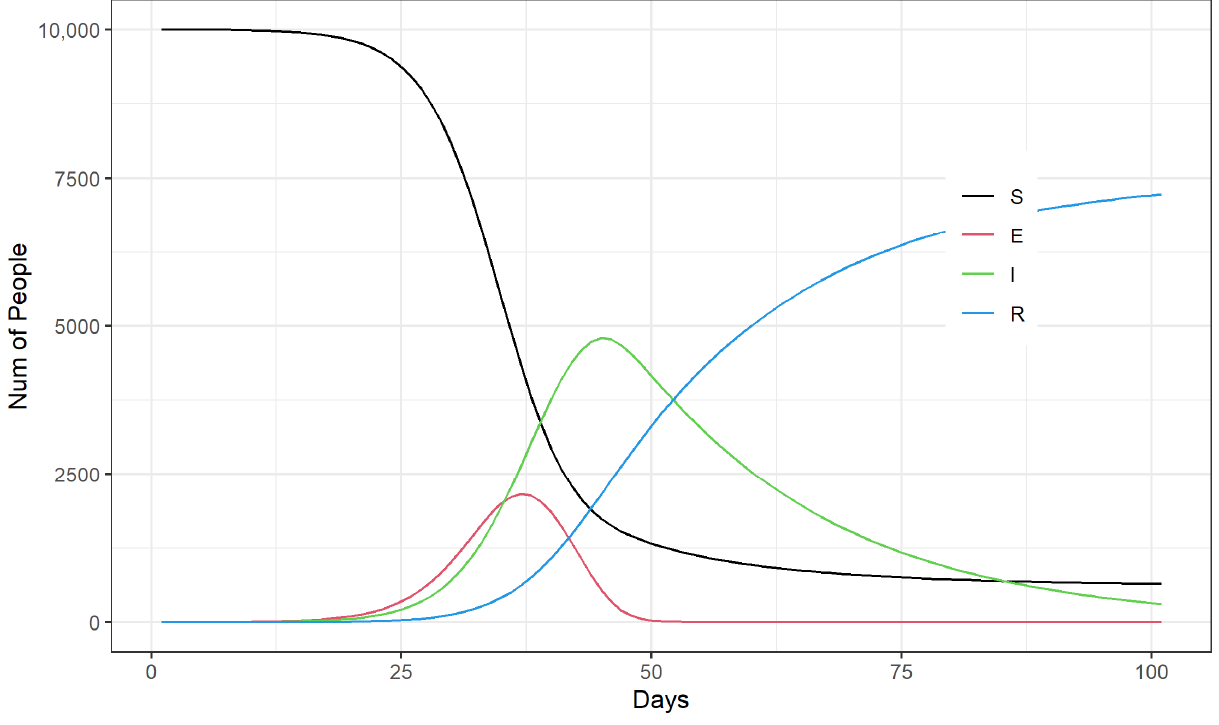
Figure A4. The influence of the daily testing capacity of 1000 person on the evolutionary process of the epidemic; (The unit of the ordinate is “person”).